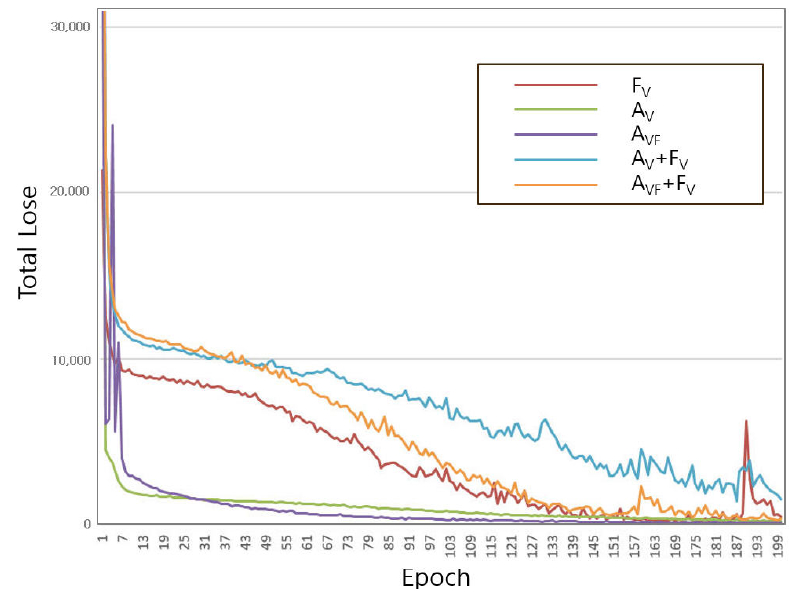
Figure 12. Comparison of total training